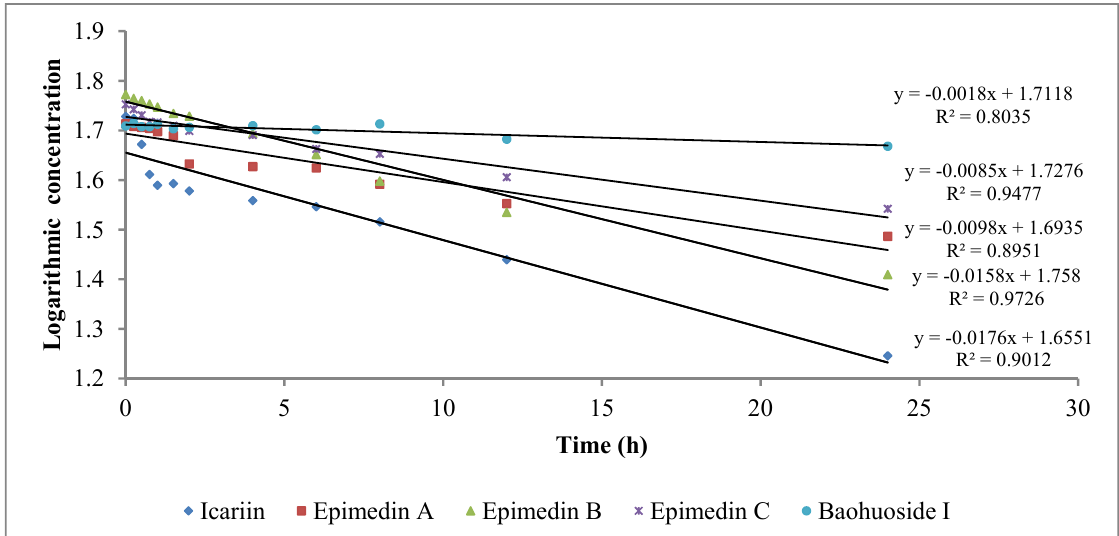
Figure 4. The metabolic rates of flavonoids by intestinal flora of